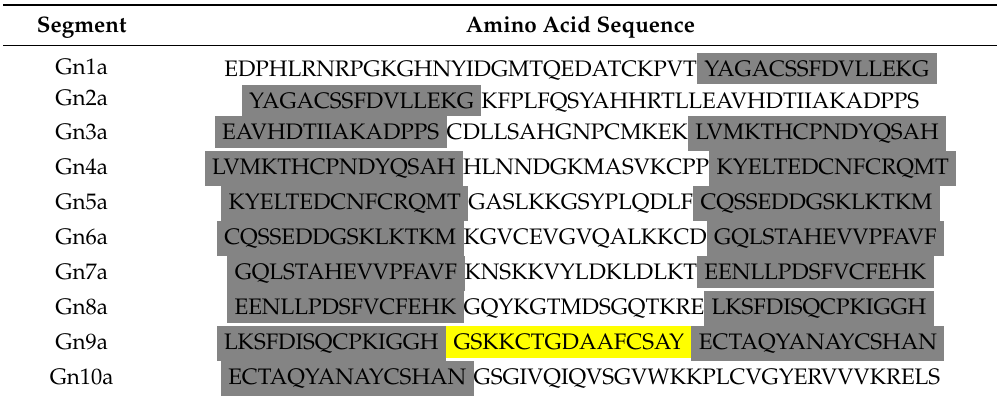
Figure 3. Western blot analysis of the type of NAb epitopes. The supernatants, collected from the Expi293F cells transfected with Gn expression vector (pCDNA3.4-Gn) and empty vector (pCDNA3.4-empty), were loaded into lane 1 and lane2, respectively. The indicated antibodies were incubated with the membrane transferred with RVFV Gn at a final concentration of 1 μg/mL. The protein reacting with anti-Gn rabbit polyclonal antibody was used as a positive control. Table 2. The amino acid sequences of truncated Gn peptides.